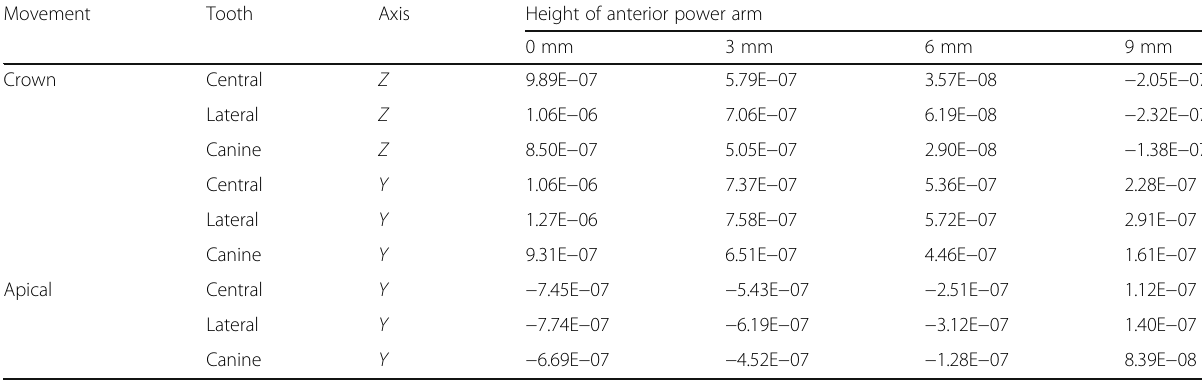
Table 5 Crown and root tipping in the distal position of the mini screw Movement Tooth Axis